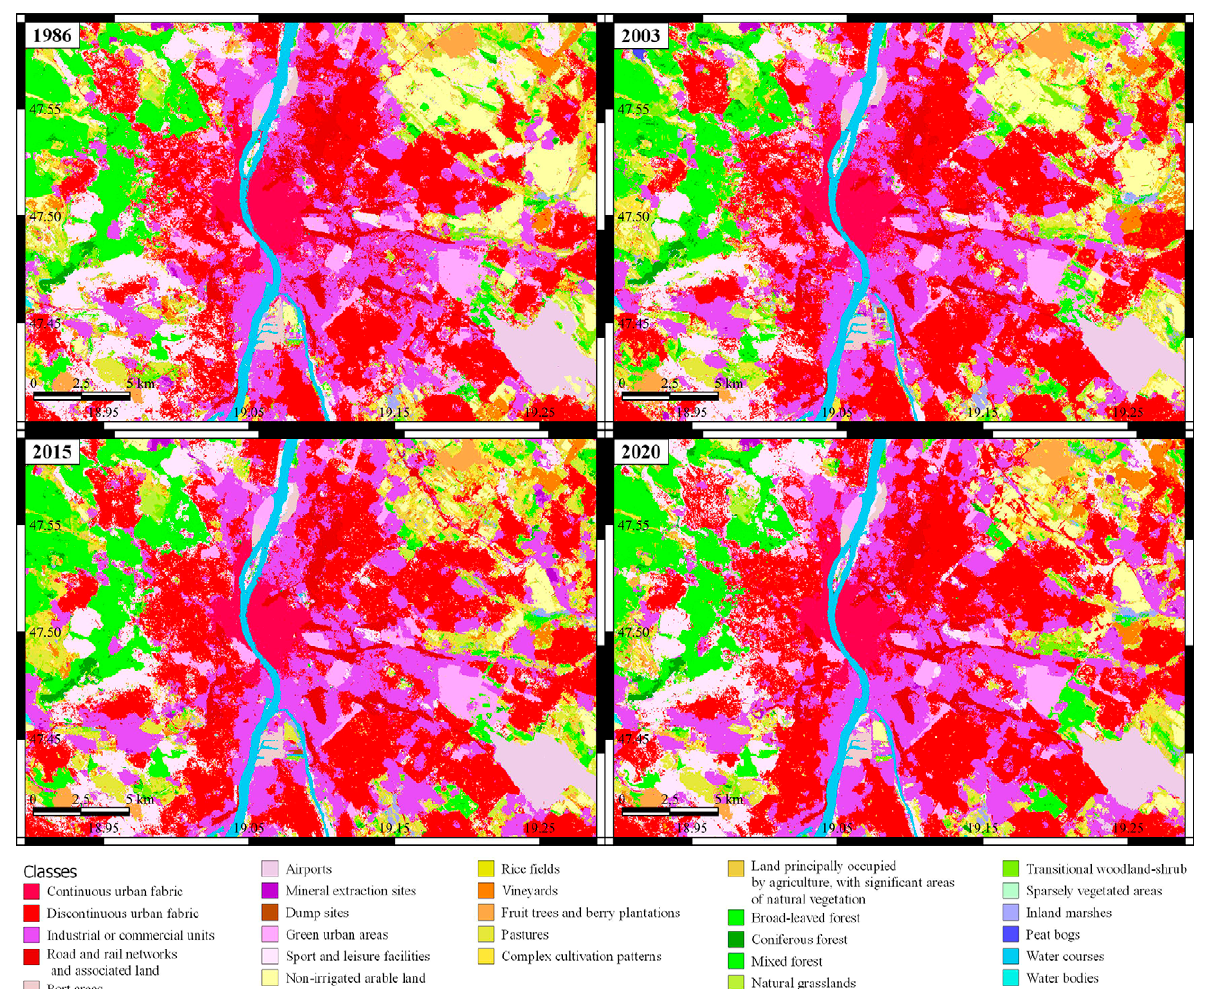
Figure 6. Classified maps of Budapest, the capital of Hungary, at different